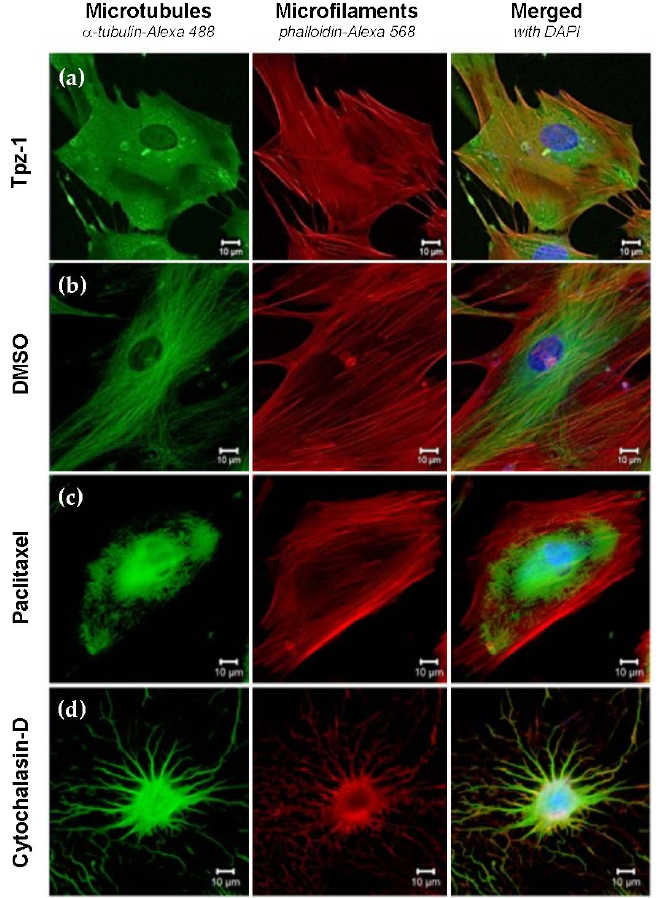
Figure 6. Tpz-1 (10 µ M) inhibits tubulin polymerization in Hs27 cells after 4 h of exposure. ( a )